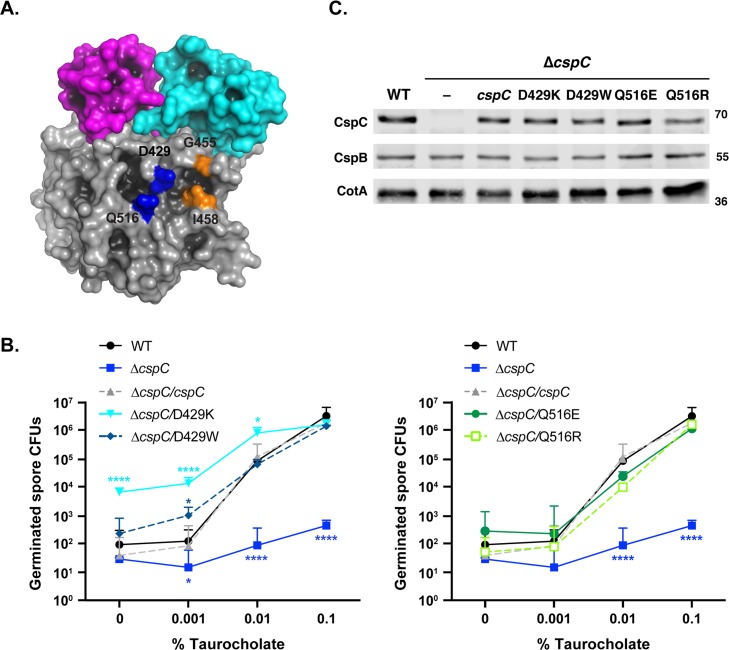
Mutation of Asp429 to Lys increases taurocholate-independent germination.(A) Space fill model of CspC highlighting the residues flanking the short loop containing R456 and G457 (orange spheres) juxtaposed to D429 and Q516 (blue spheres). A shallow cavity on the surface of the subtilase-like domain is visible between these four residues. The image is rendered to enhance cavity contrast using PyMOL (Schrödinger, Inc.) (B) Germinant sensitivity of cspC mutant spores encoding mutations in Asp429 and Gln516 when plated on BHIS containing increasing concentrations of taurocholate. The number of colony forming units (CFUs) that arose from germinating spores is shown in two graphs to improve readability. The mean and standard deviations shown are based on three replicates performed on three independent spore purifications. Lower error bars have been omitted to improve readability. Statistical significance relative to wild type was determined using a two-way ANOVA and Tukey’s test. **** p < 0.0001, * p < 0.05. (B) Western blot analyses of CspC and CspB levels in D429 and Q516 mutant spores. CotA serves as a loading control. The results are representative of three biological replicates performed on three independent spore preps.